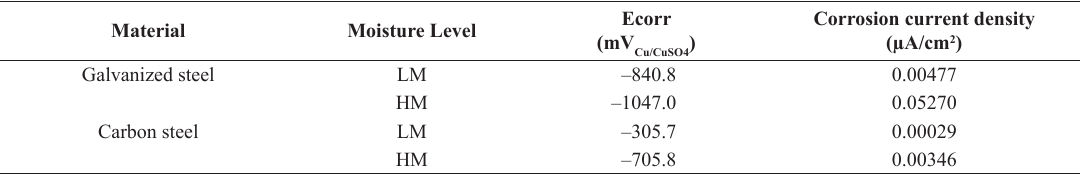
Table 2. Electrochemical parameters obtained by Tafel slope to galvanized steel and carbon steel buried in soil. (HM: High moisture e LM: Low moisture).